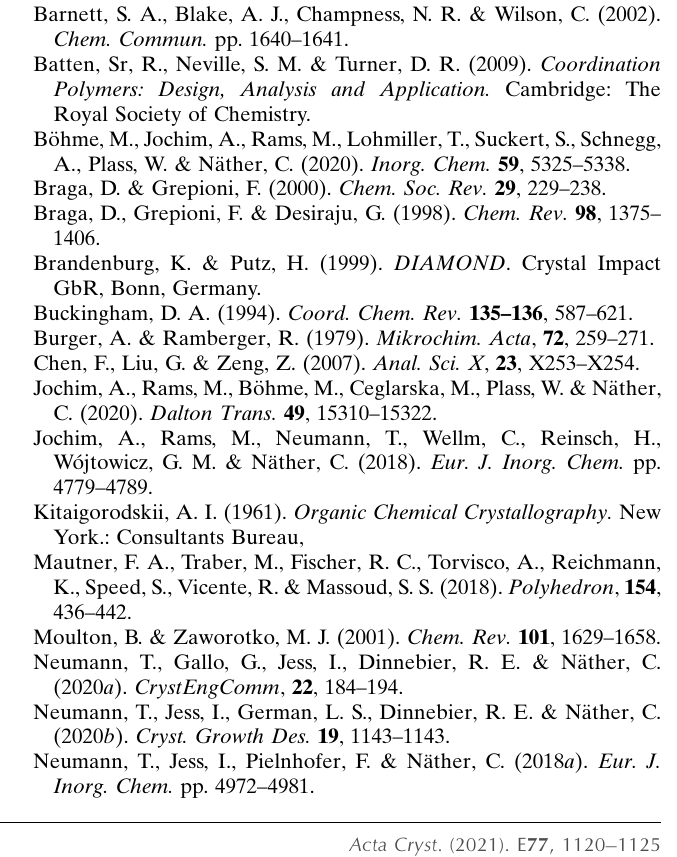
Crystal data Chemical